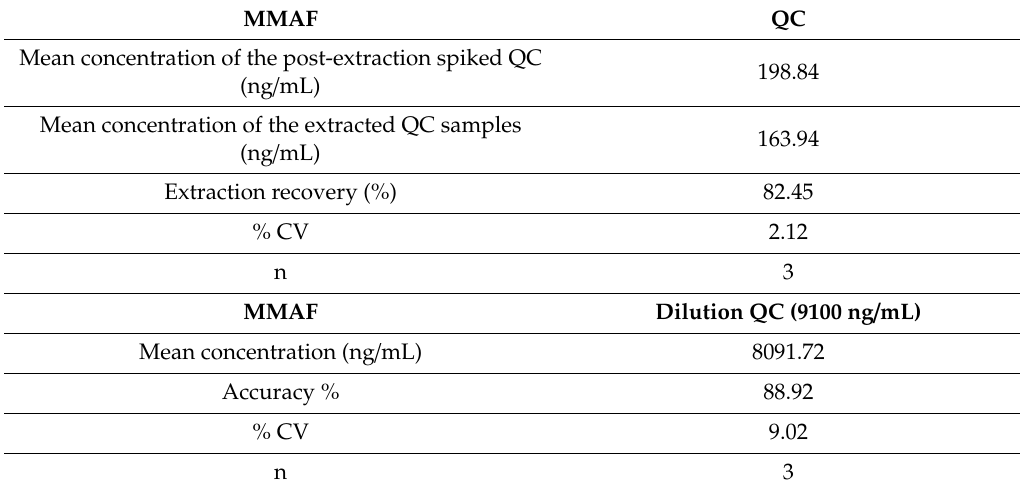
Table 4. Extraction recovery and dilution integrity results of MMAF (monomethyl auristatin F) in rat plasma.